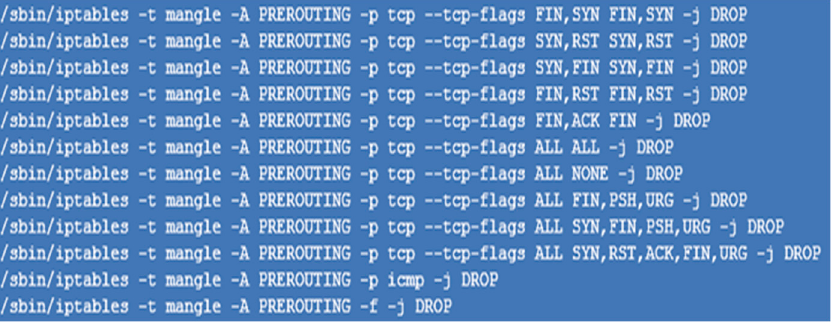
Figure 4. Ostinato settings environment ( a ) set up packet transmission and, ( b ) generate packets.